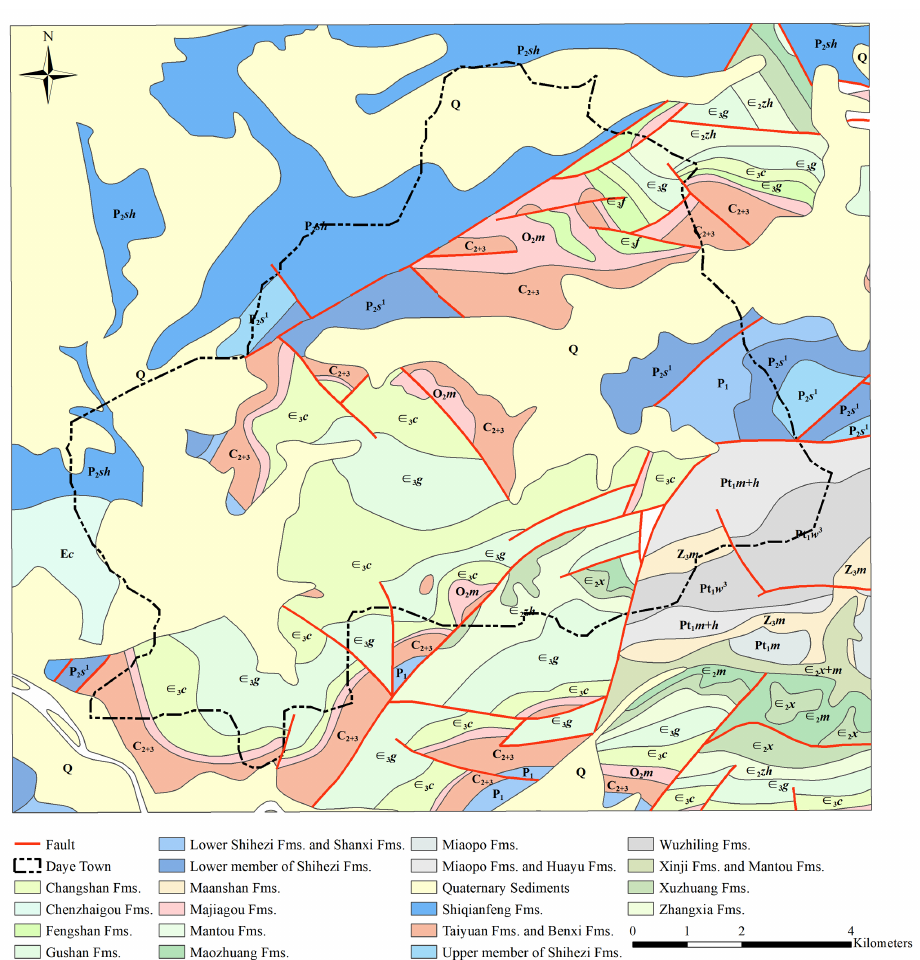
Figure 2. Geological map of Daye